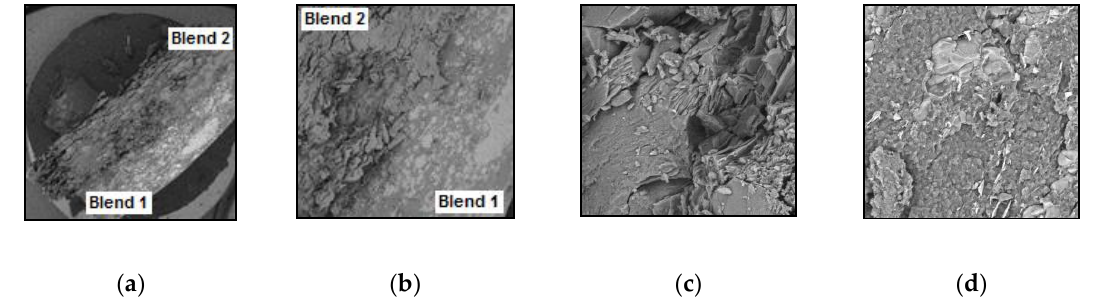
Figure 5. Scanning Electron Micrographs of the bilayer tablet at different magnification. ( a ) Bilayer tablet (×20), ( b ) Bilayer tablet at (×80), ( c ) Blend 1 on bilayer tablet (×1000) and ( d ) Blend 2 on bilayer tablet (×1000).